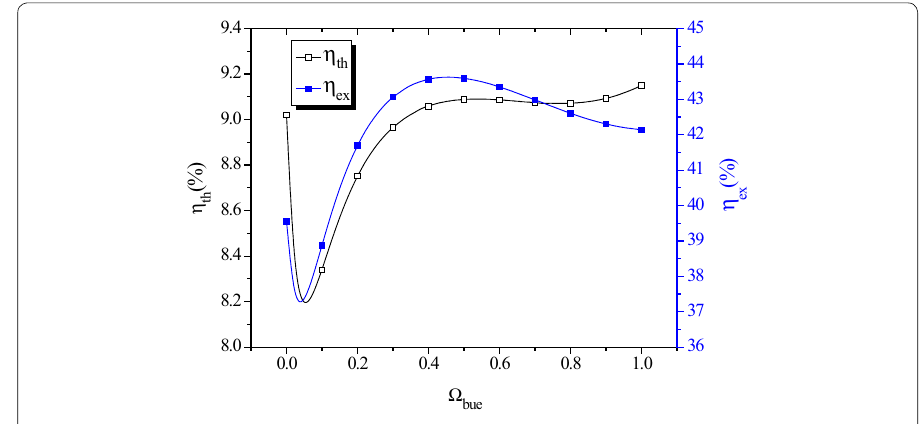
Fig. 3 η th and η ex versus Ω